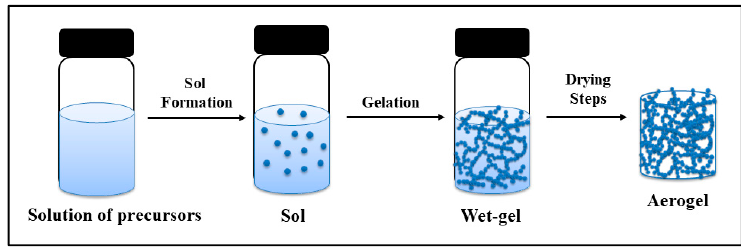
Figure 1. Schematic representation of sol-gel method to produce aerogels.